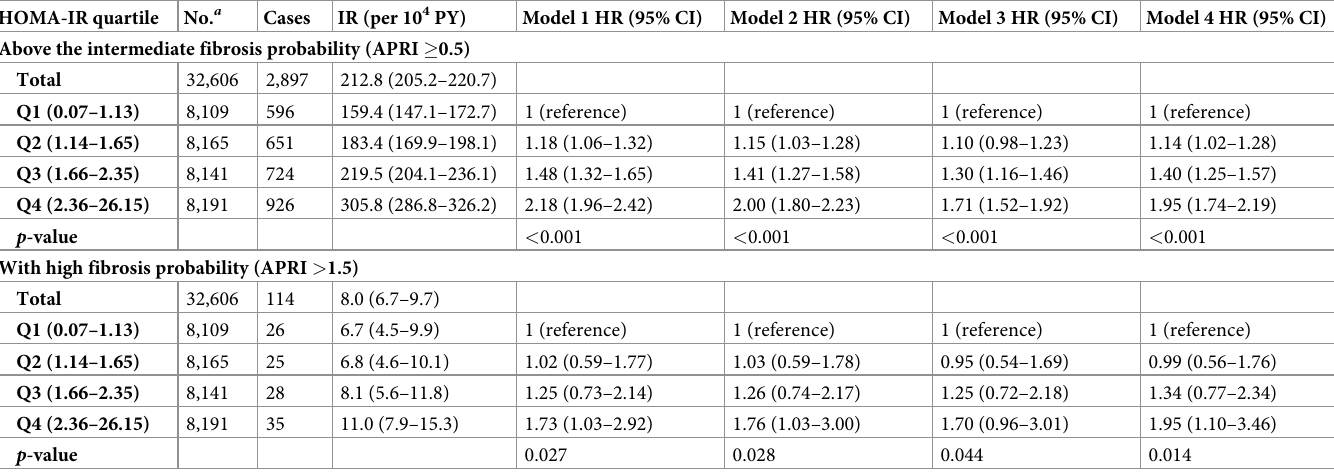
Table 2. Hazard ratios for the development of advanced liver fibrosis by HOMA-IR quartile at baseline. HOMA-IR quartile No.